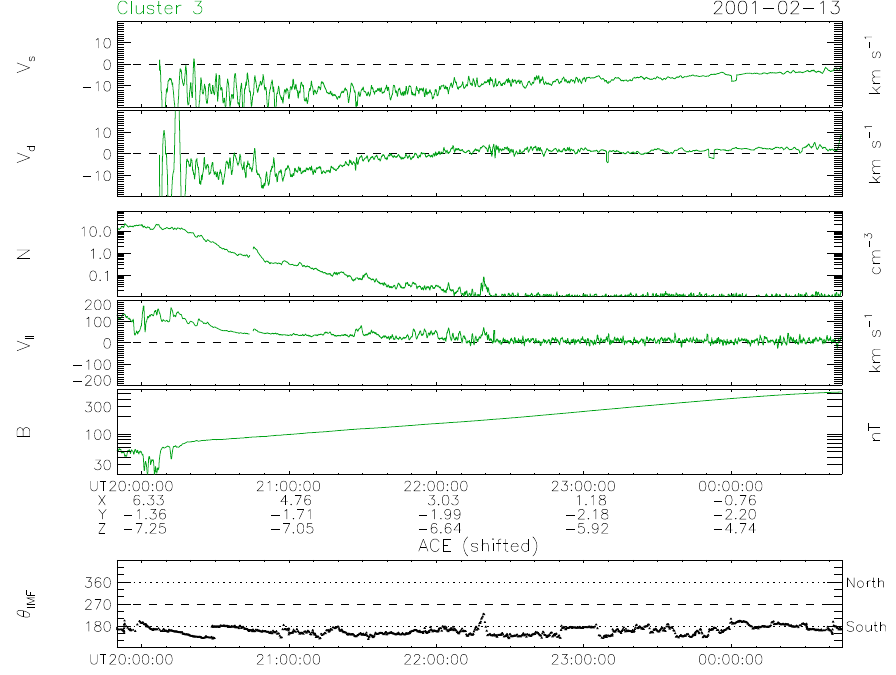
Fig. 3. Measured time-series for an inbound pass of Cluster-3 over the southern polar cap on 13 February 2001. The top two panels show the convection velocities after applying a 30s-smoothing to the full-resolution EDI data; V s is the component along the ˆ e s -axis introduced in the text, V d the component along ˆ e d . The 3rd and 4th panels show the ion density, N, and the parallel component of the bulk velocity, V k , measured by CIS-HIA, the 5th panel the magnetic field strength measured by FGM. Universal time, and GSE positions are shown along the bottom of the latter panel. The bottom panel finally shows the IMF clock-angle derived from the ACE magnetic field measurements, shifted for the propagation delay. Values of 0 ◦ and 180 ◦ denote fields that when projected into the GSM (Y, Z)-plane are pointing due north and due south,